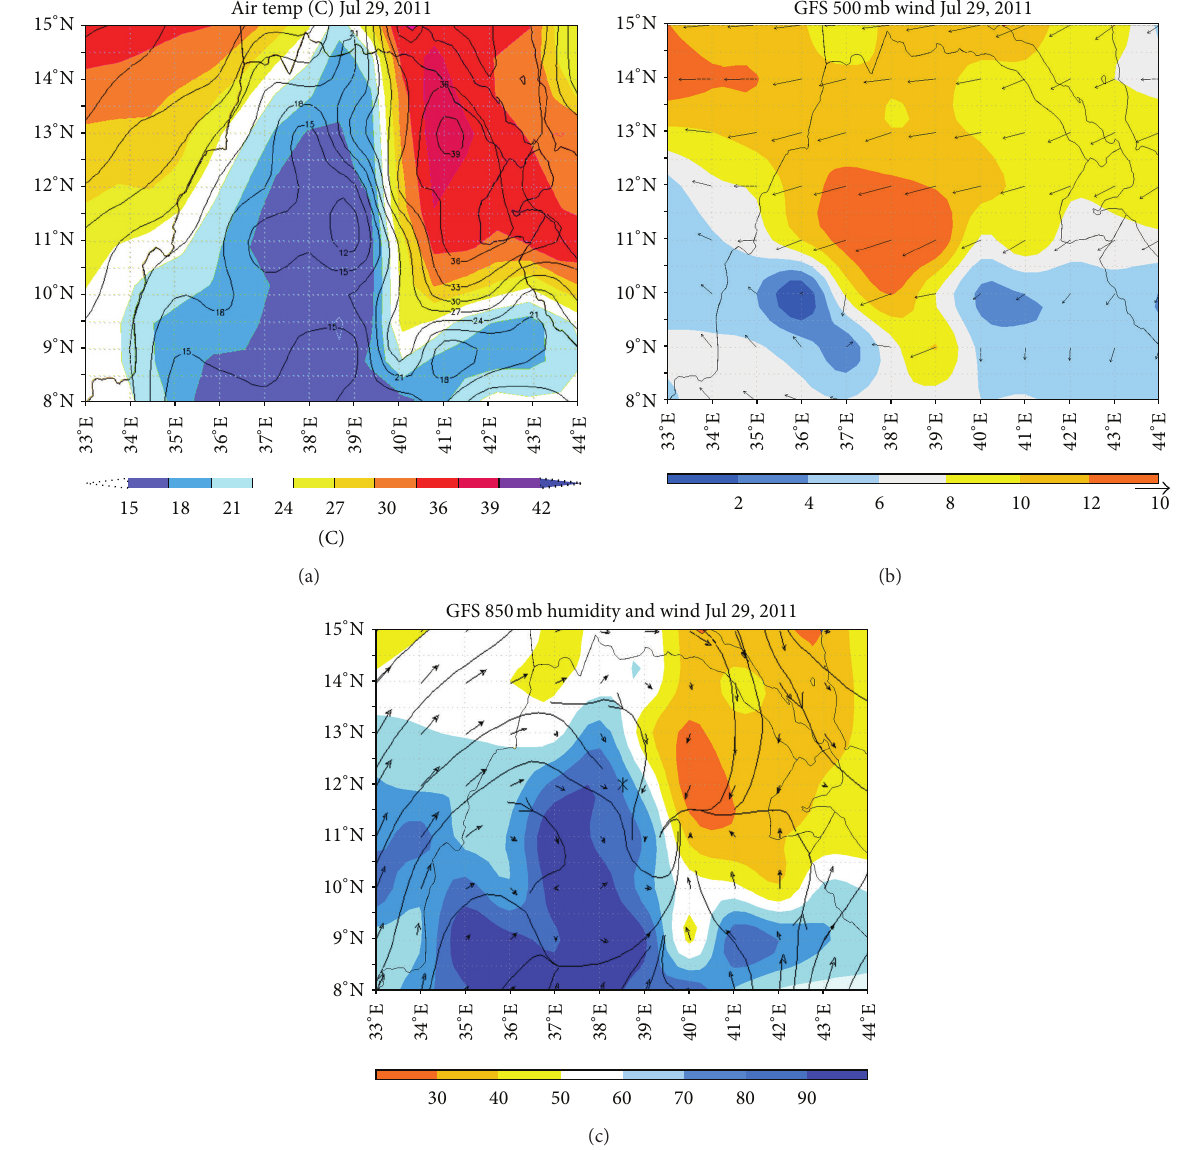
Figure 4: Regional weather features on 29 July, 2011: (a) surface air temperature (GFS contoured, ECMWF shaded), (b) GFS 500 mb wind (speed shaded), and (c) GFS 850 mb relative humidity (shaded), and 850 mb wind vectors (max = 12 m/s) and